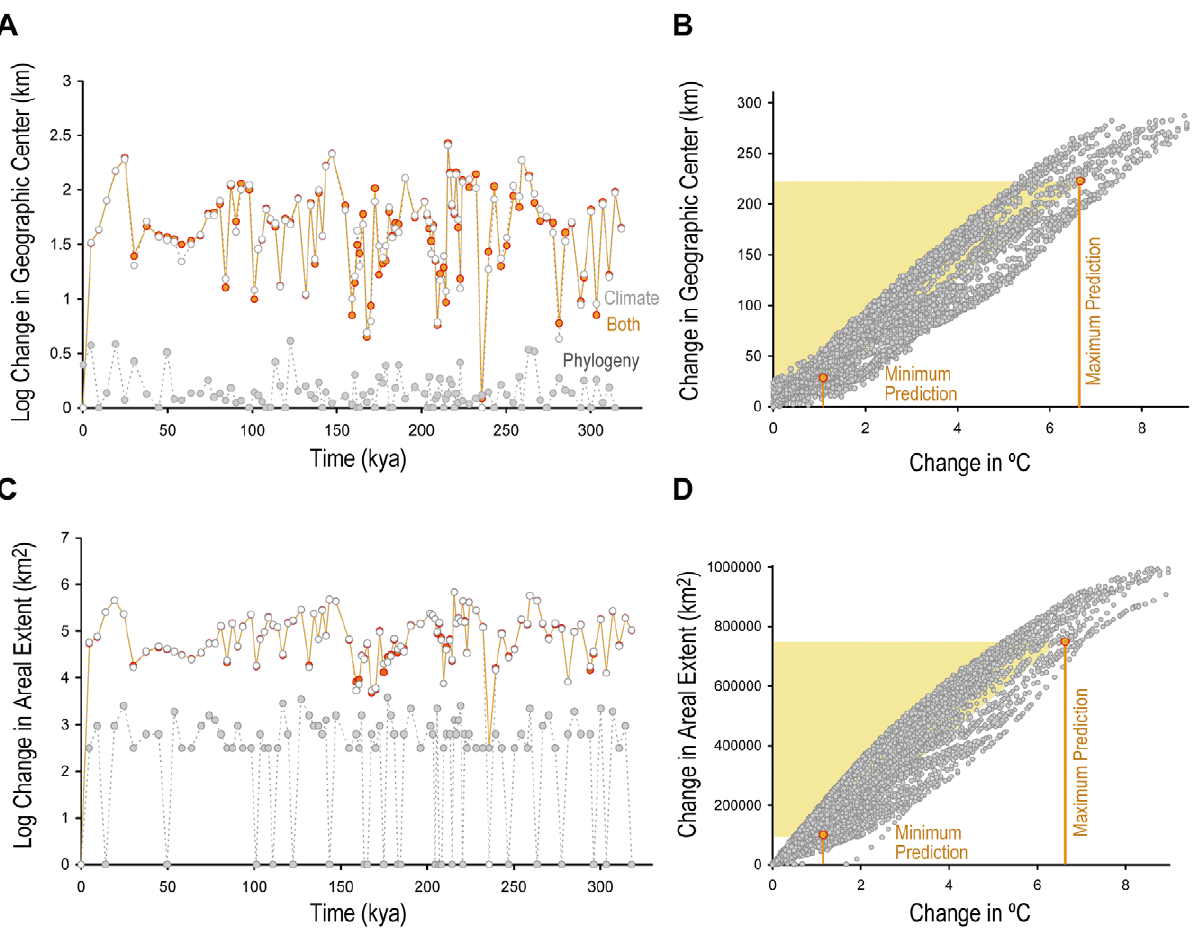
Figure 7. Average change in species’ distributions of suitable habitat over the last 320 ky. A, Time series of change in geographic center (km). Change due to climate and phylogeny are modeled separately to identify the contributions of each in a model incorporating change due to both climate and phylogeny. B, Change in geographic center as it relates to temperature ( u C). C, Time series of change in areal extent (km 2 ). D, Change in areal extent as it relates to temperature change ( u C). The shaded area indicates increase in global temperature by the end of the 21 st century predicted by IPCC 2007.